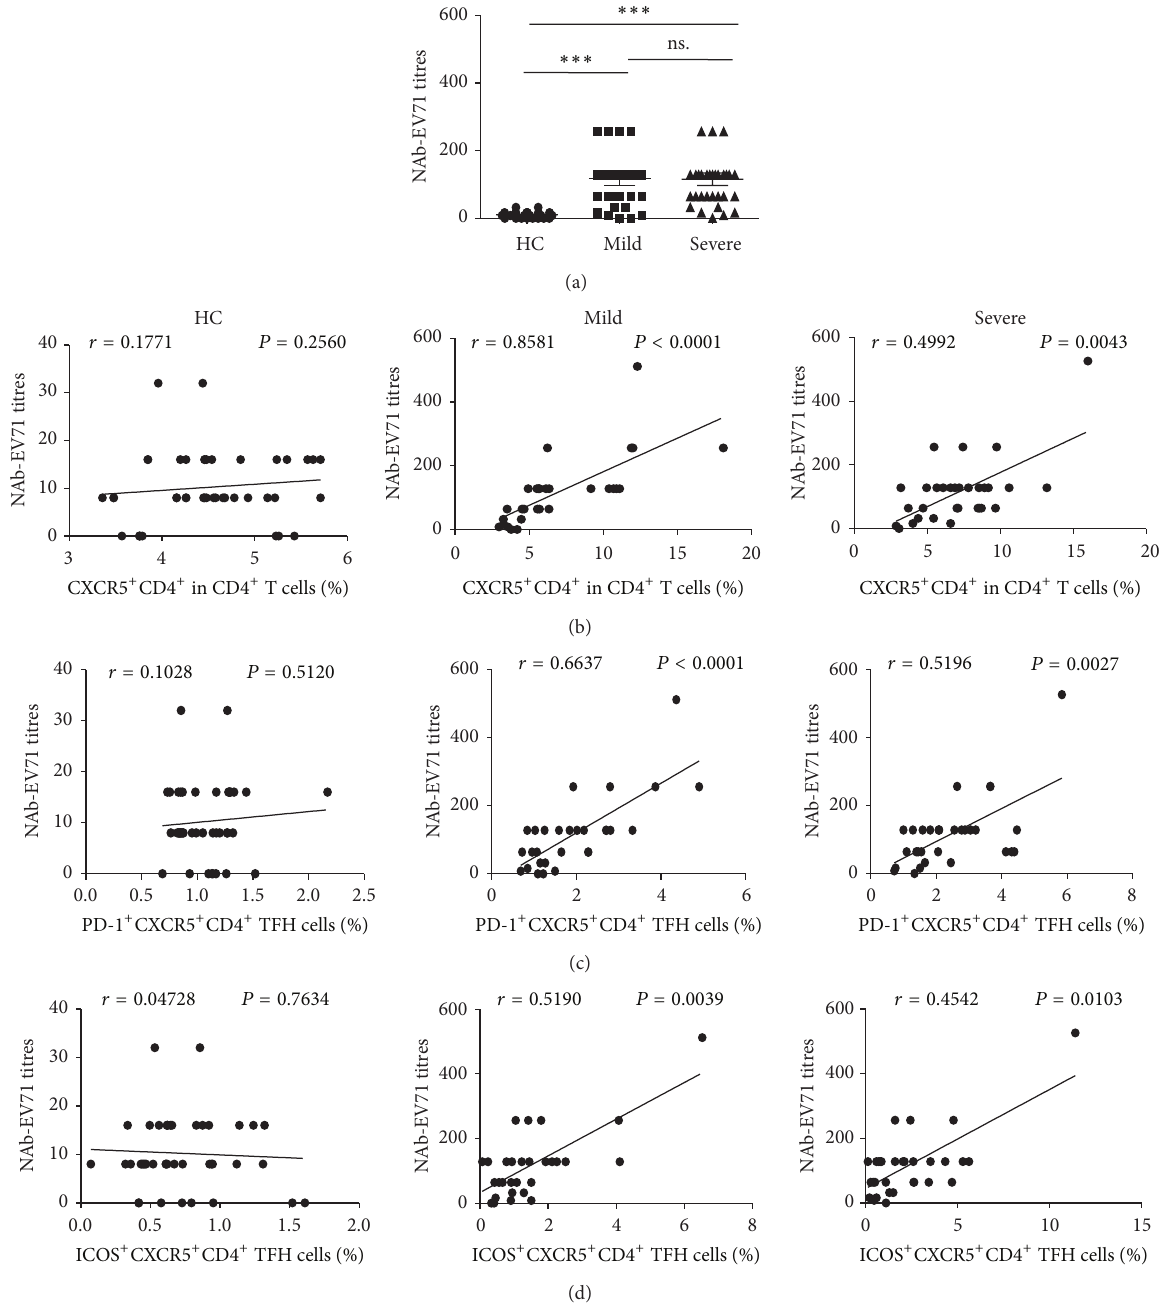
Figure 3: Correlation of specific NAb-EV71 titres and circulating CXCR5 + CD4 + TFH cells with PD- 1 high and ICOS high expression in EV71- infected patients. (a) Titres of specific NAb-EV71 in sera from HC and EV71-infected patients including mild and severe cases. Relationship between the titres of specific NAb-EV71 and the frequency of circulating CXCR5 + CD4 + TFH cells (b), PD-1 + CXCR5 + CD4 + TFH cells (c), and ICOS + CXCR5 + CD4 + TFH cells (d). Data shown were the mean ± SD. The horizontal lines show the median. ∗ 𝑃 < 0.05 ; ∗∗ 𝑃 < 0.01 ; ∗∗∗ 𝑃 < 0.001 ; ns.: no significant